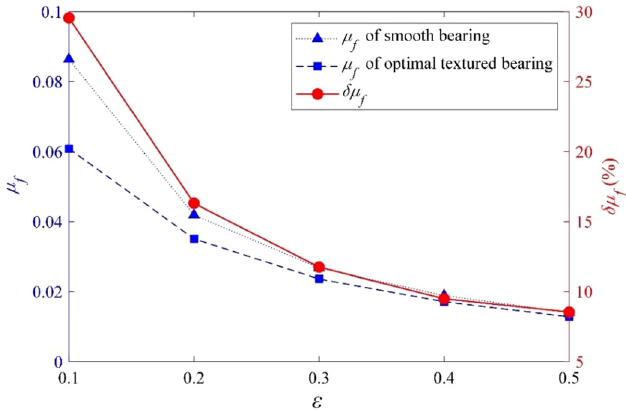
Fig. 13. m f and dm f under e =0.1 – 0.5, ’ = 0, N =1000 rpm.